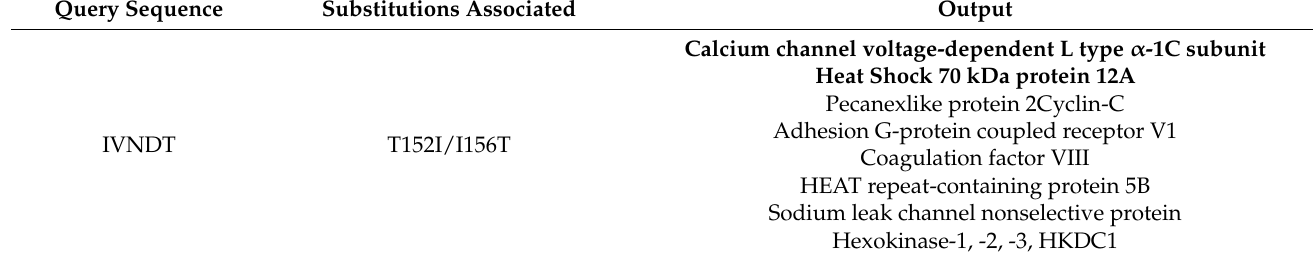
Table 1. Host proteins obtained from query sequence alignment using Blastp. The proteins highlighted in bold are the only ones which fulfill the criteria of selection as candidates for molecular mimicry. Query